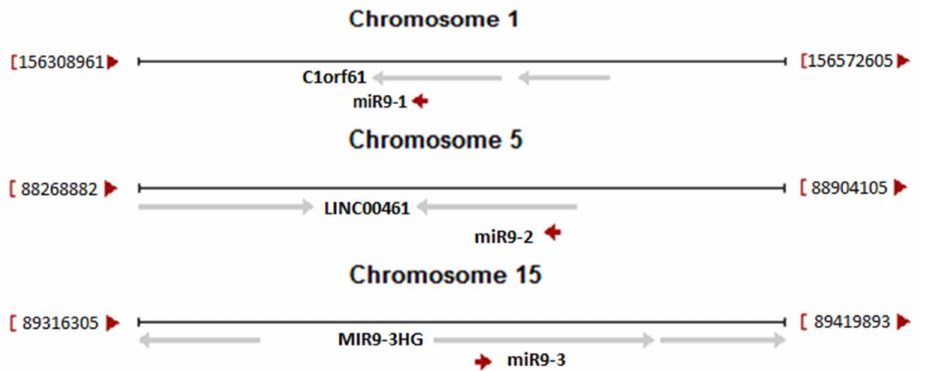
Figure 2. Pre-miR-9-1, pre-miR-9-2 and pre-miR-9-3 localization in human genome (red arrows). Some of host genes are also indicated (gray arrows). From C1orf61 27 transcripts could be transcribed; 6 of them are protein-coding, 15 of them contain pre-miR-9-1 sequence. LINC00461 codes 16 non-protein coding transcripts; 10 of them contain pre-miR-9-2 sequence. From MIR9-3HG 12 non-protein coding transcripts could be produced, but only 3 transcripts contain pre-miR-9-3 sequence. Figure was created based on NCBI data for listed sequences (MIR9-1 ID: 407046, MIR9-2 ID: 407047, MIR9-3 ID: